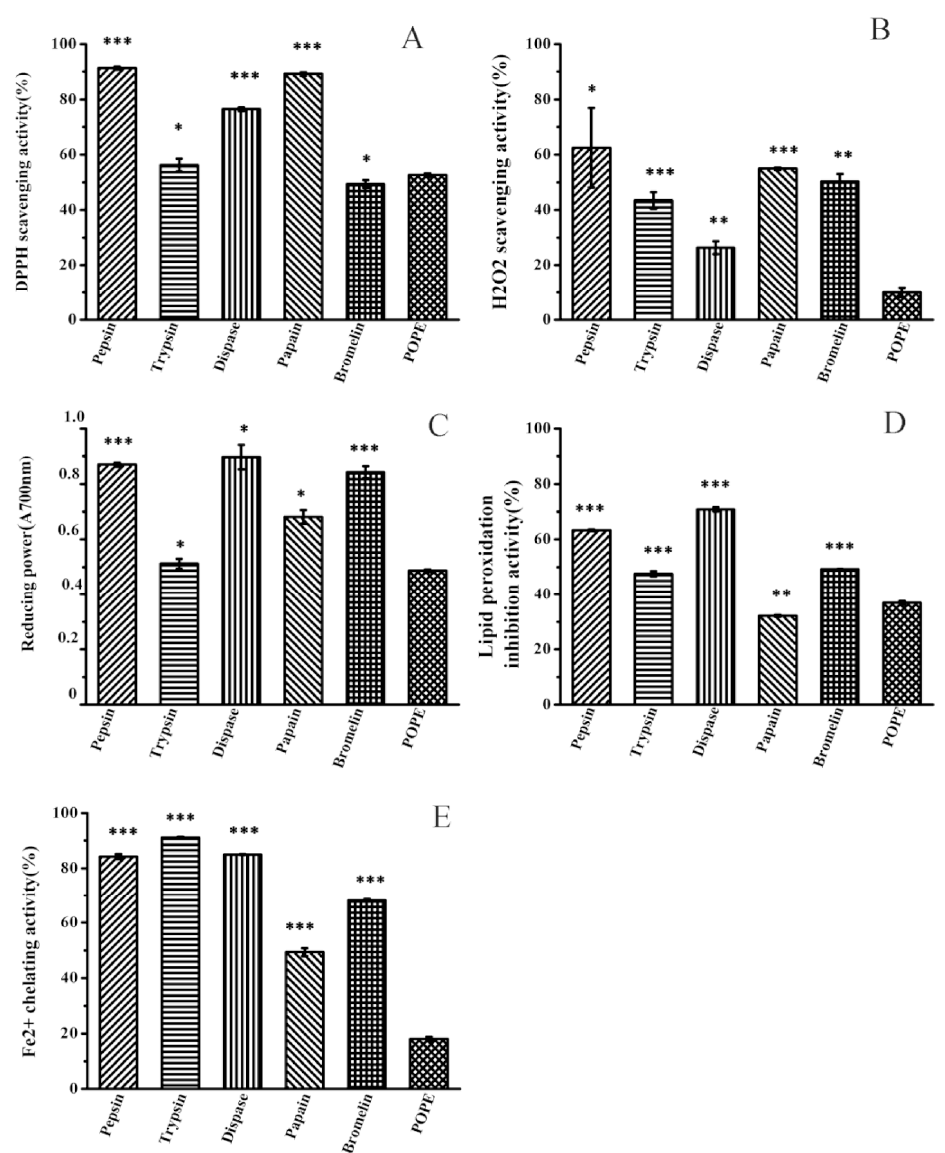
Figure 1. Comparison of in vitro antioxidant e ff ects of P. ostreatus protein hydrolysate: Pep, Pepsin-treated; Try, trypsin-treated; Dis, dispase-treated; Pap, papain-treated and Bro, bromelin-treated. ( A ) DPPH scavenging activity. ( B ) Hydrogen peroxide scavenging activity. ( C ) Reducing power. ( D ) Inhibitory e ff ect on lipid peroxidation. ( E ) Fe 2 + ion chelating activity. The values are presented as the mean values ± SD (n = 3). (***) p < 0.001, (**) p < 0.01, and (*) p < 0.05 compared with the POPE group. Table 3. Comparison of in vitro antioxidant effects of P. ostreatus protein hydrolysate: Pep, Pepsin-treated; Try, trypsin-treated; Dis, dispase-treated; Pap, papain-treated and Bro, bromelin-treated. The values are presented as the mean ± SD.